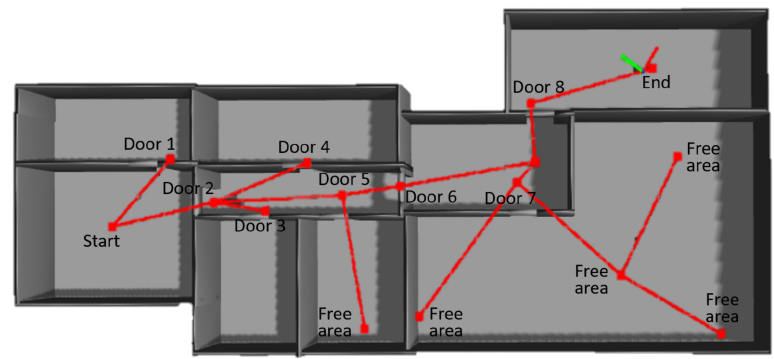
Figure 8. Example of a topological map build with exploration in a simulated environment. Red lines correspond to edges and red dots to nodes.